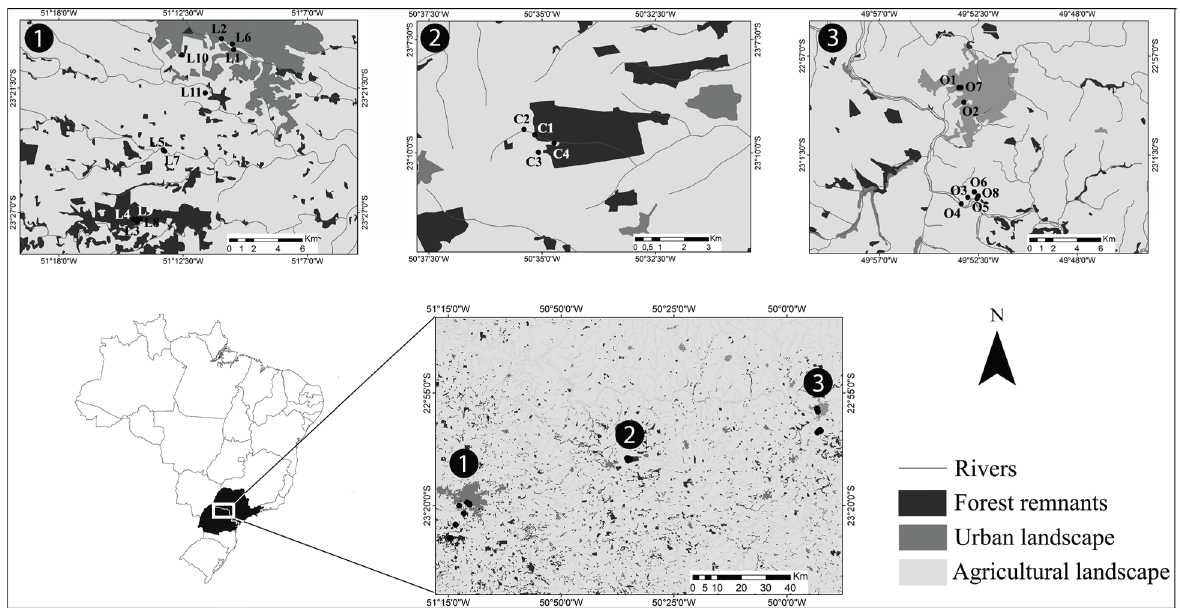
Figure 1 - Sampled water bodies (black dots) located in the Mesophytic Semideciduous Forest within Atlantic Forest Domain, between October 2010 and February 2011 in northern of the state of Paraná and southeast of the state of São Paulo, southern Brazil. 1 = londrina (l); 2 = Cornélio Procópio (C); 3 = Ourinhos (O). Codes of water bodies as presented in Table